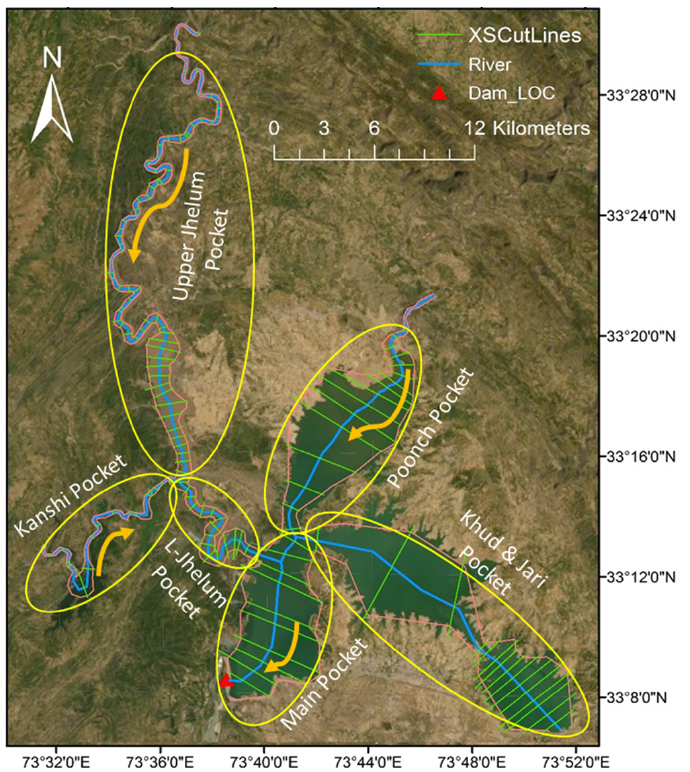
Figure 3. Mangla Reservoir pockets and cross sections location.